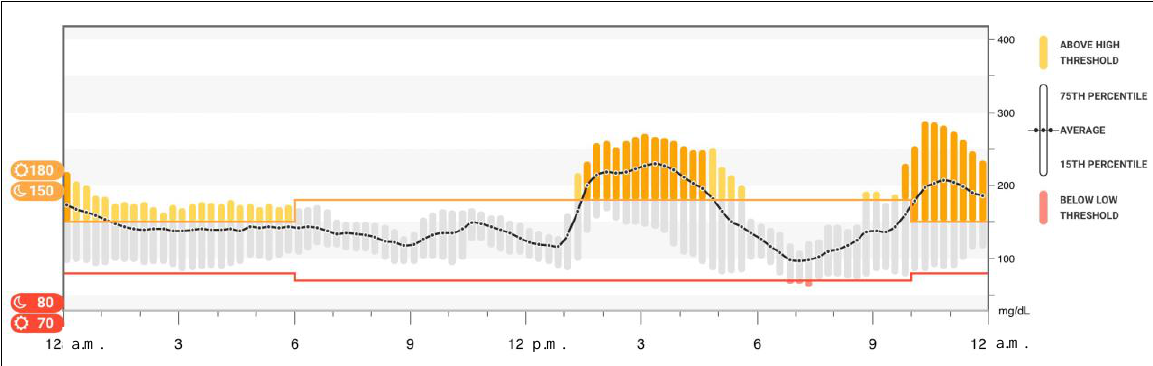
Figure 2. Glucose data reproduced from Dexcom ® CGM Clarity software (Dexcom, Inc., San Diego, CA, USA): the graph shows the glucose trend averaged over 14 days. No evidence of hypoglycemia in the early hours of the morning was found in the months following steroid replacement.